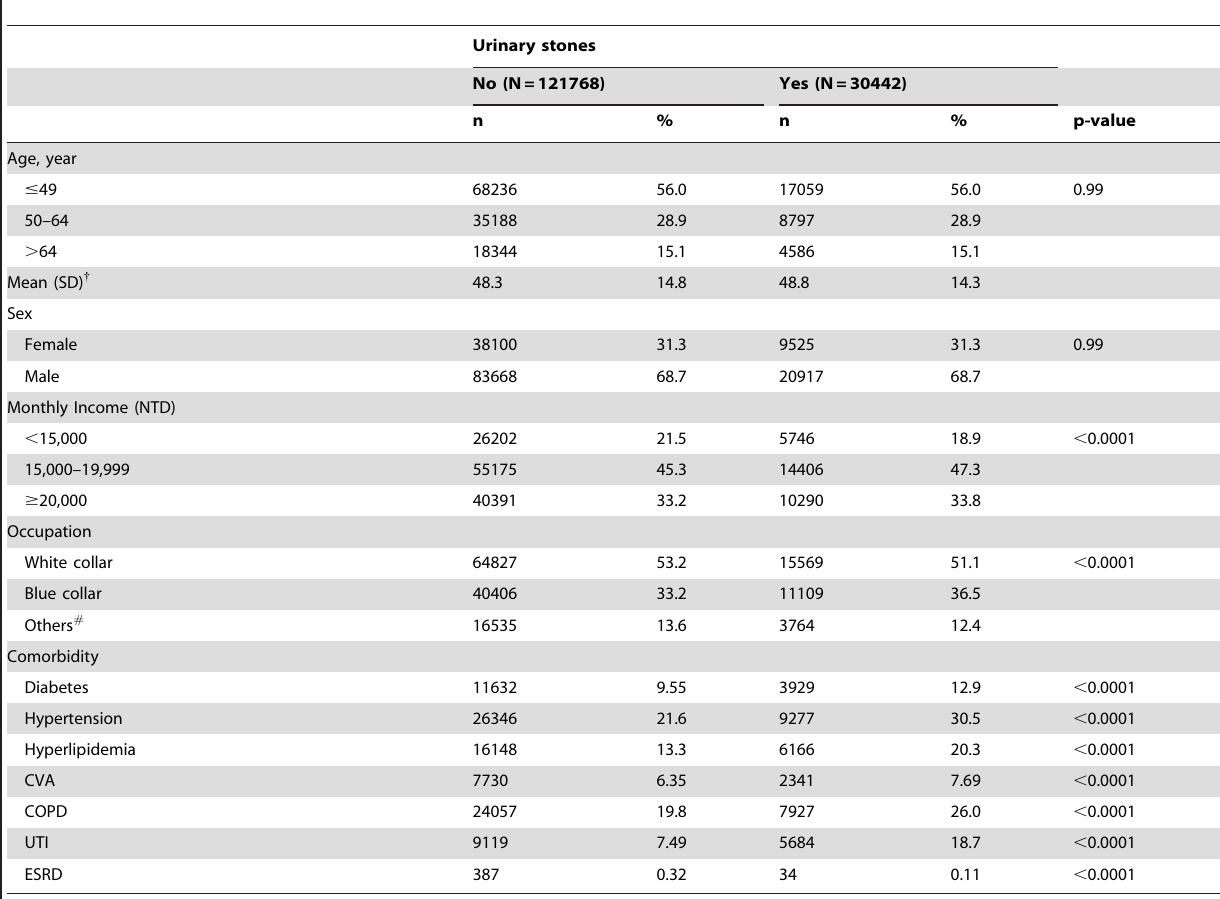
Table 1. Comparison of demographics and comorbidity between urinary stones patients and non- urinary stones